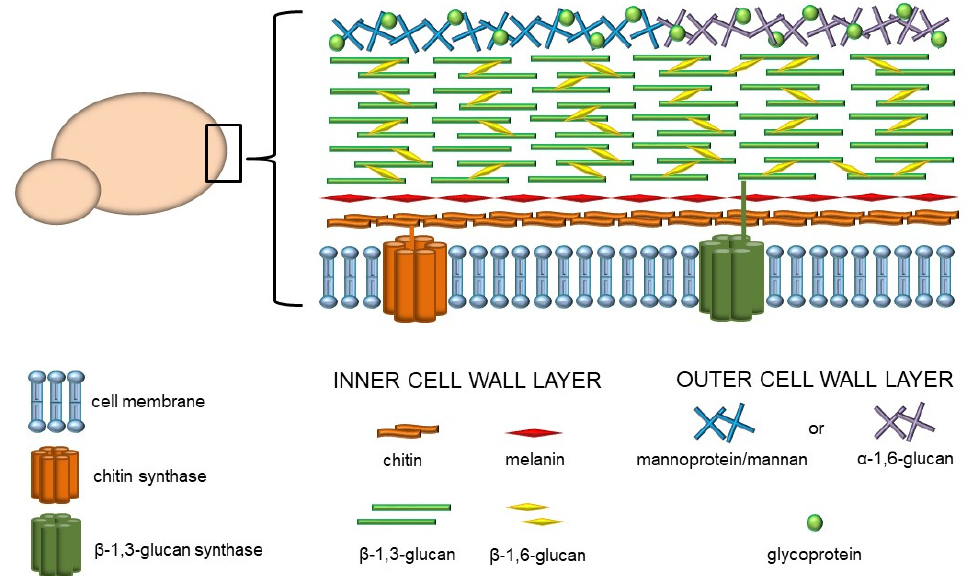
Figure 1. Structural organization and composition of the fungal cell wall.